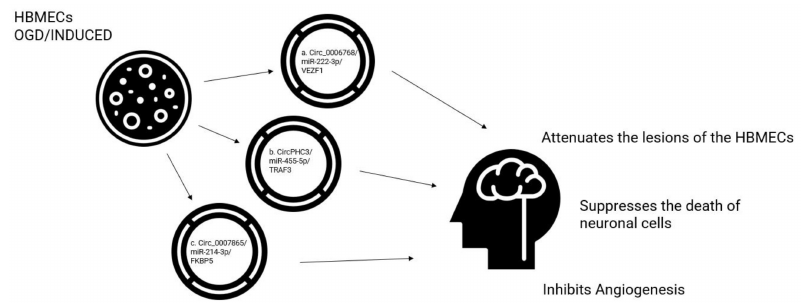
Figure 3. The effect of circRNAs in OGD-treated HMBECs. (a) Upregulated circ_0006768 attenu- ates the lesion of HBMEC OGD induced through the upregulation of VEZF1 and the inhibition of miR-222-3p. (b) Inhibition of circPHC3 suppresses the death of neuronal cells by sponging of miR- 455-5p to activate the expression of TRAF3. (c) Overexpression of circ0007865 promotes the inhibition of angiogenesis by modulating the miR-214-2p/FKBP5 axis. circRNA: circular RNA; HMBEC: human brain microvascular endothelial cells; miR: microRNA; VEZF1: vascular endothelial zinc finger 1; FKBP5: FK506-binding protein 5; TRAF3: TNF receptor associated factor